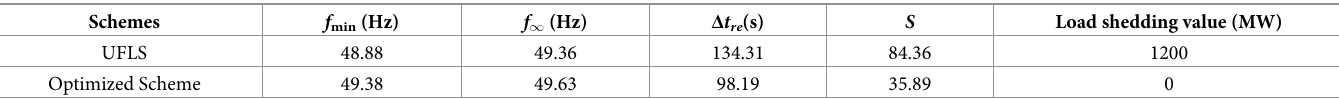
Table 13. Simulation analysis results (Case